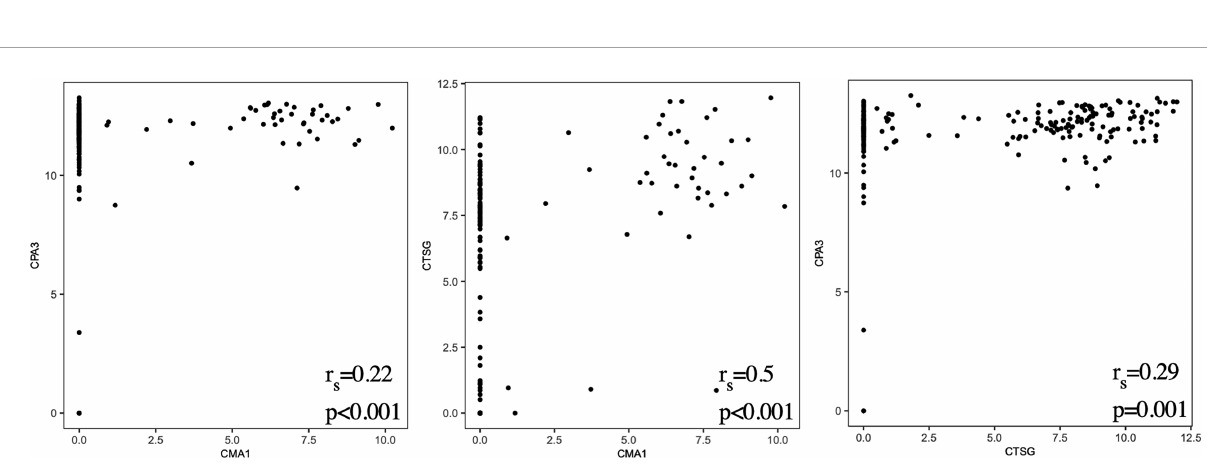
FIGURE 5 Scatter plots of CPA3/CMA1/CTSG expression from all four donors and Spearman ’ s rank correlation coef fi cients (r s ).